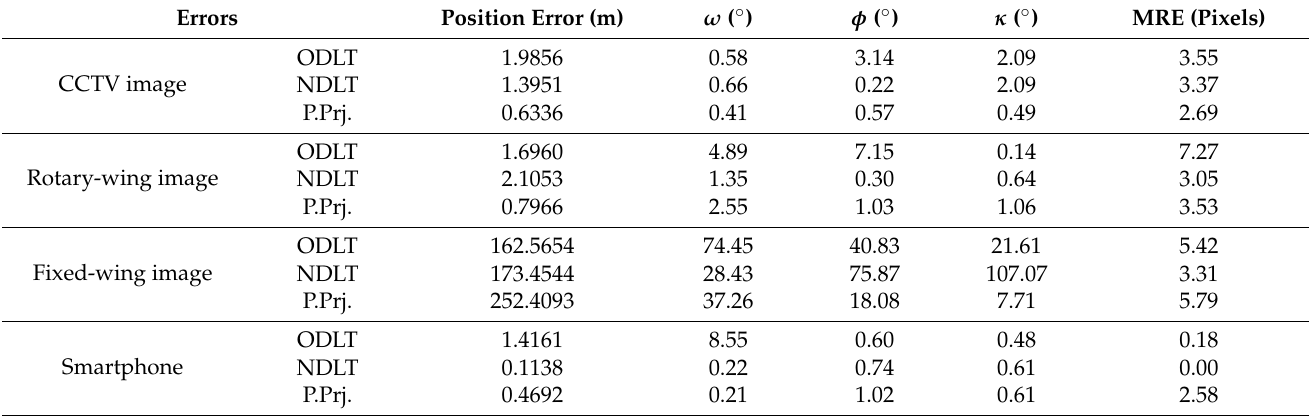
Table 10. Error summary for each sensor